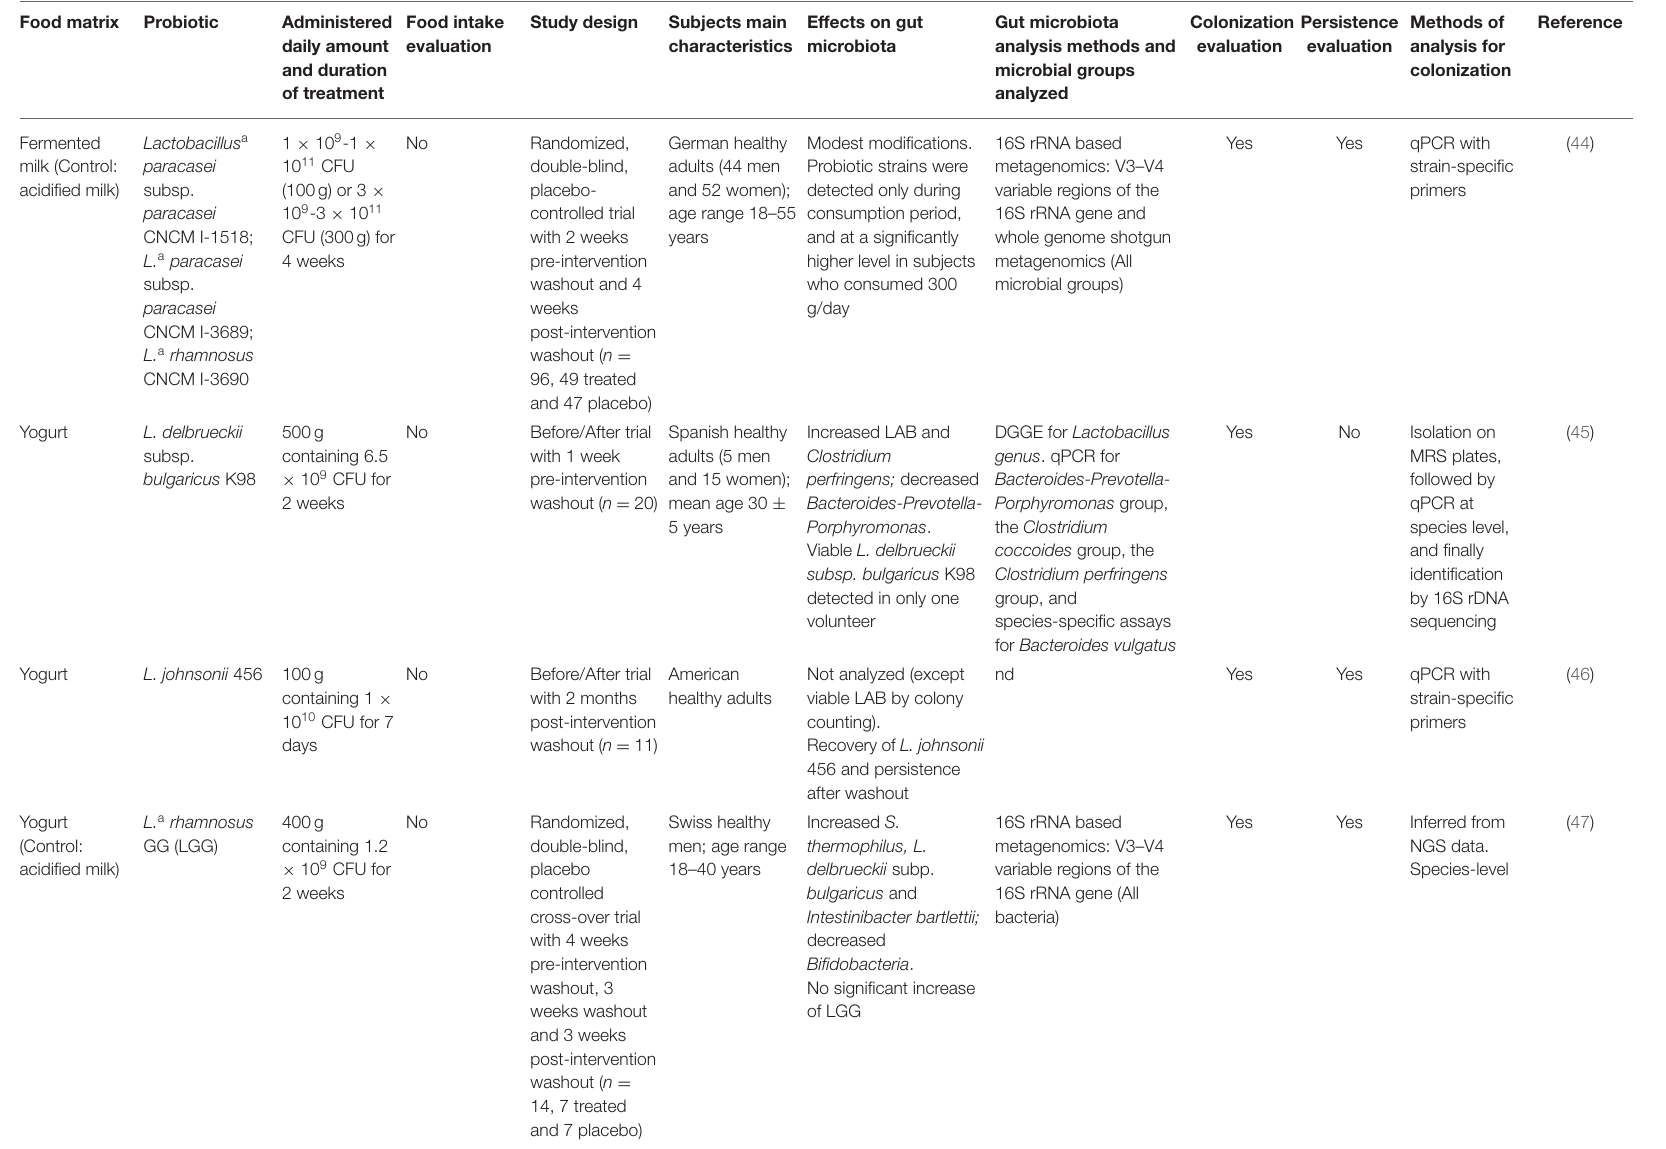
TABLE 4 | Human intervention studies using fermented foods containing probiotic Lactobacillus and Lacticaseibacillus